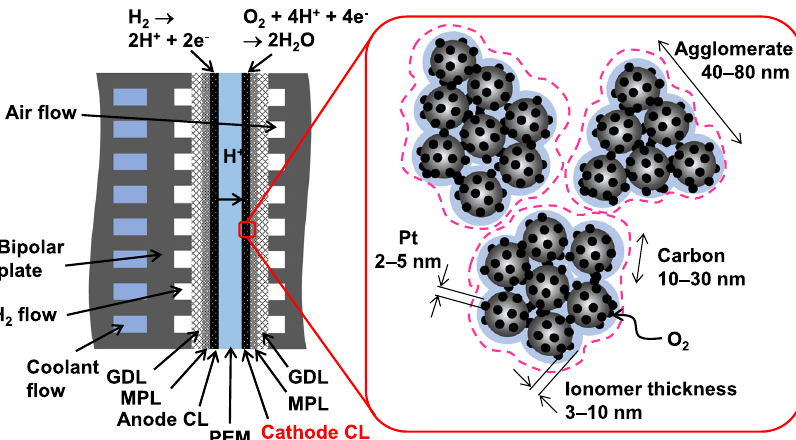
Fig. 1 Schematic of PEFC and cathode CL. PEM, MPL, and GDL denote the proton exchange membrane, microporous layer, and gas diffusion layer,